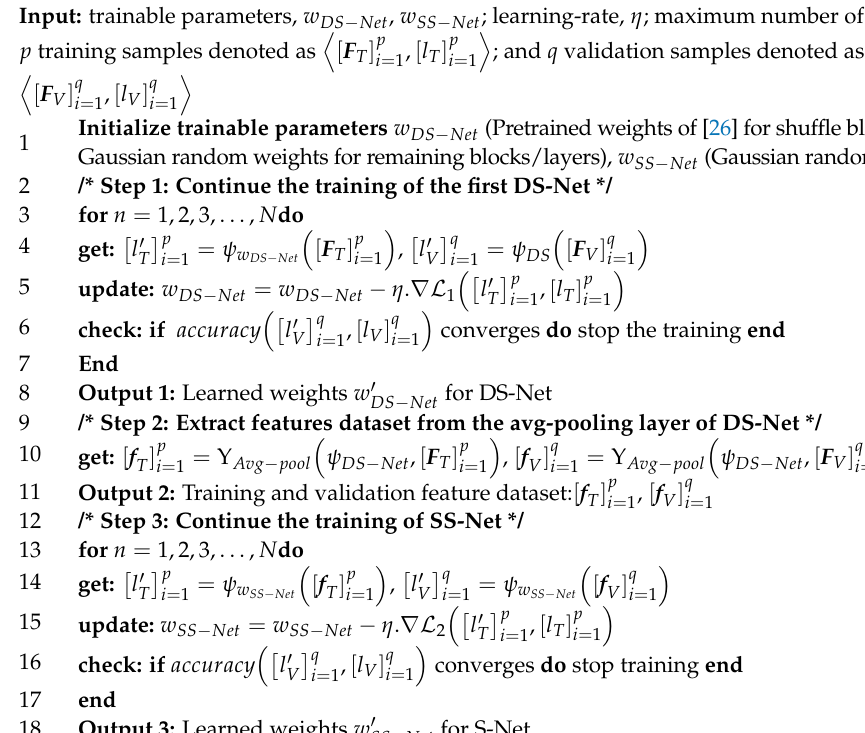
Algorithm 1: Two-step training stop